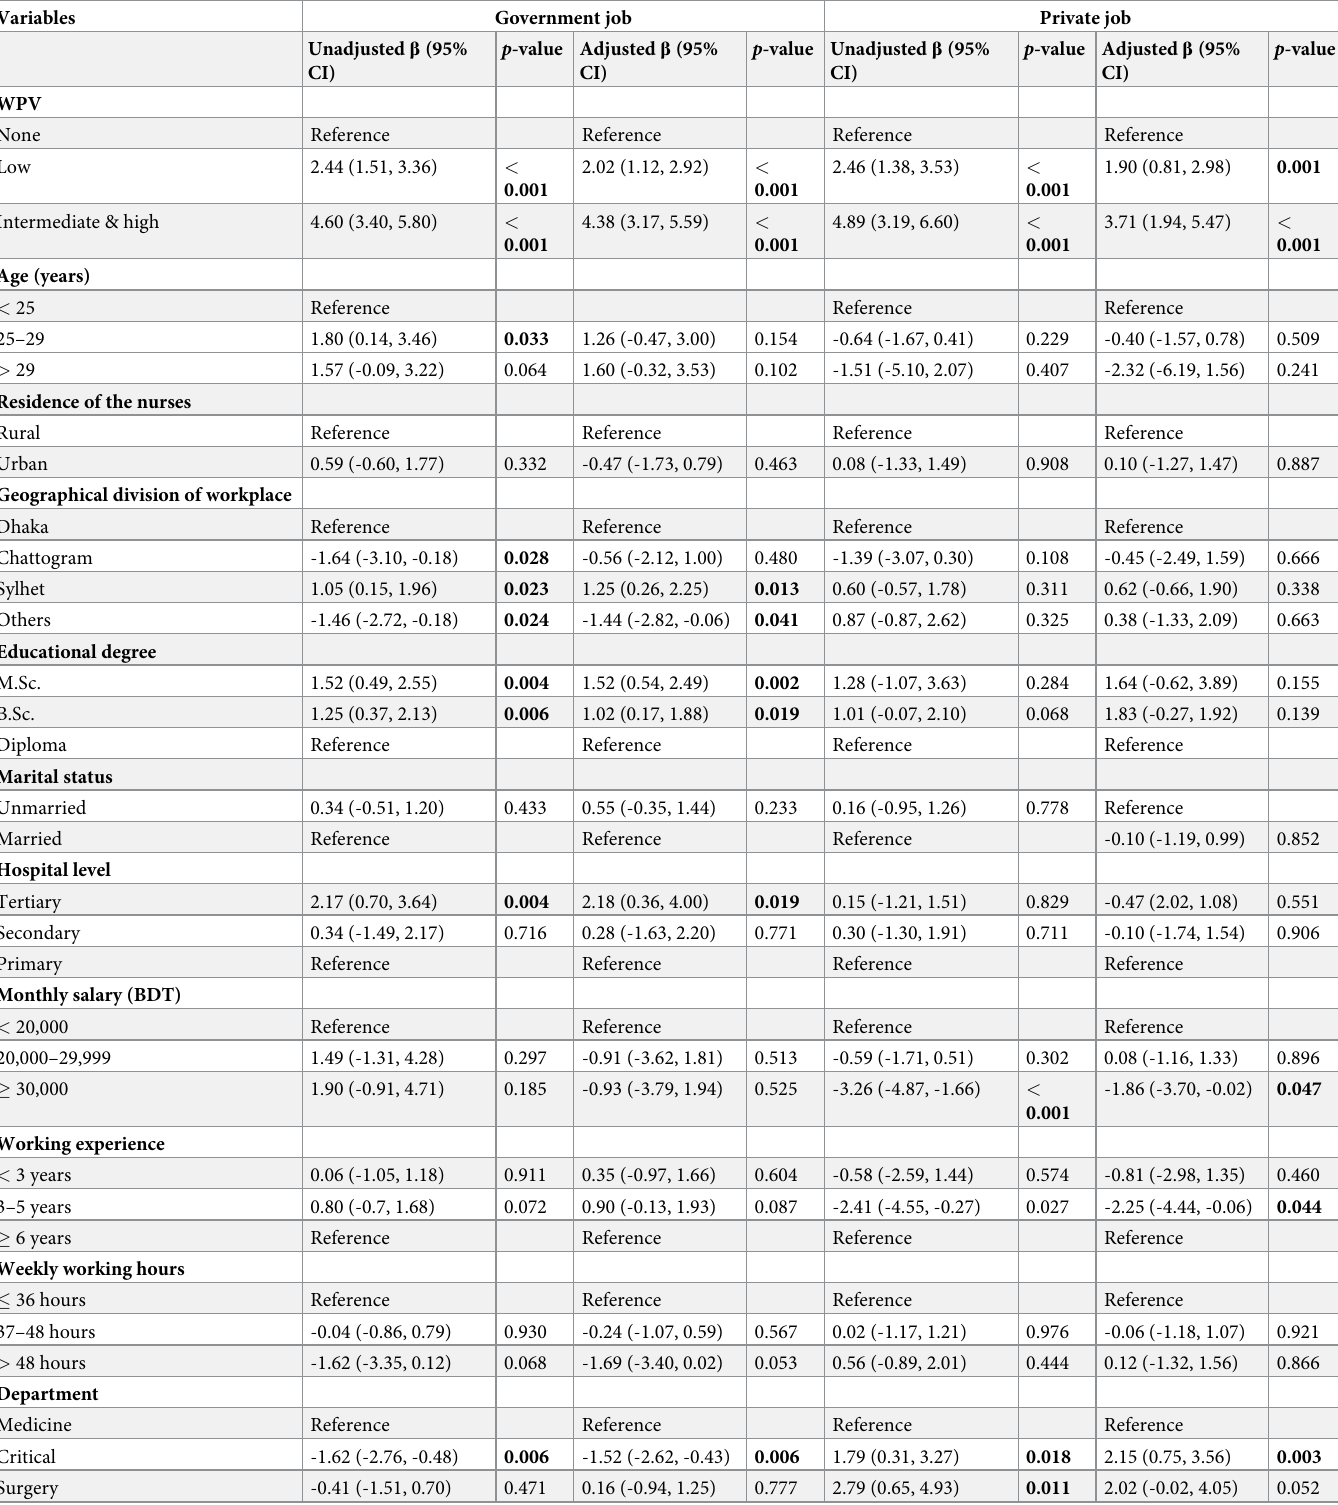
Table 4. Linear regression model to find the association of turnover intention with workplace violence and other study variables stratified by type of job (n =